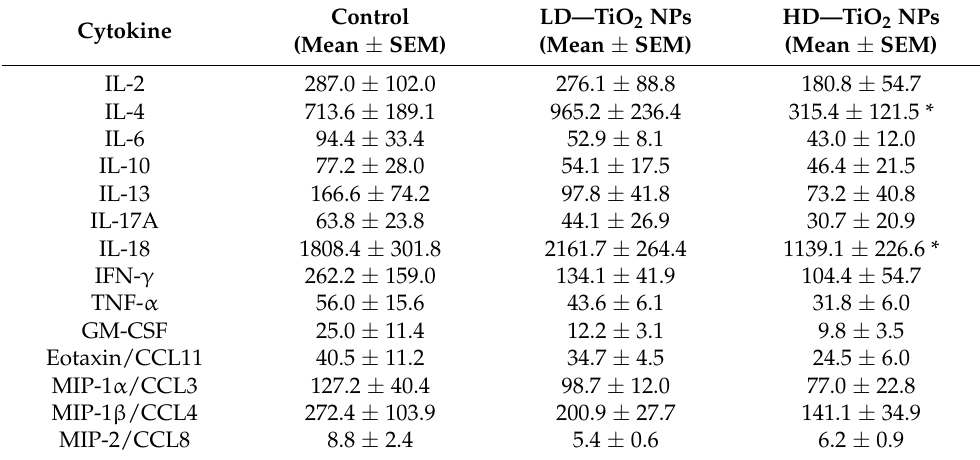
Table 2. Concentrations of cytokines and chemokines in spleen cell culture supernatants in mice after seven-week inhalation of TiO 2